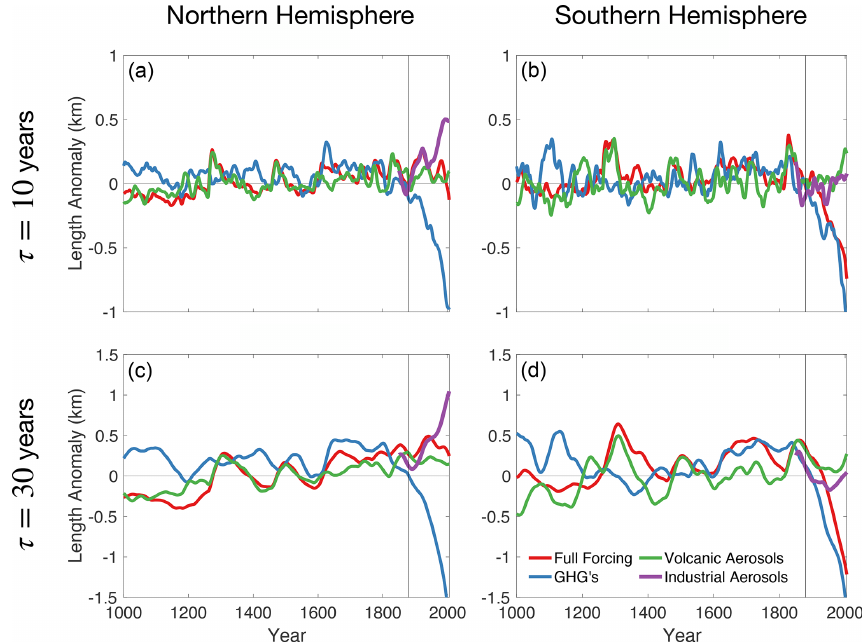
Figure 7. Contributions of individual forcing factors to glacier-length variability over the last millennium. Results are shown for response timescales of τ = 10 years (a, b) and τ = 30 years (c, d) . The left column (a, c) shows the average of all Northern Hemisphere glaciers in our network, and the right column (b, d) shows the average of all Southern Hemisphere glaciers. Colors represent the contributions from individual forcing factors, which we approximate from the ensemble-mean time series of summer temperature and winter precipitation within each single-forcing ensemble. The individual forcing factors are greenhouses gases (blue), volcanic aerosols (green), and industrial aerosols (purple). The red line shows the combined influence of all forcing factors diagnosed from the full 13-member ensemble.The gray vertical line marks the transition from the pre-industrial to modern eras at year